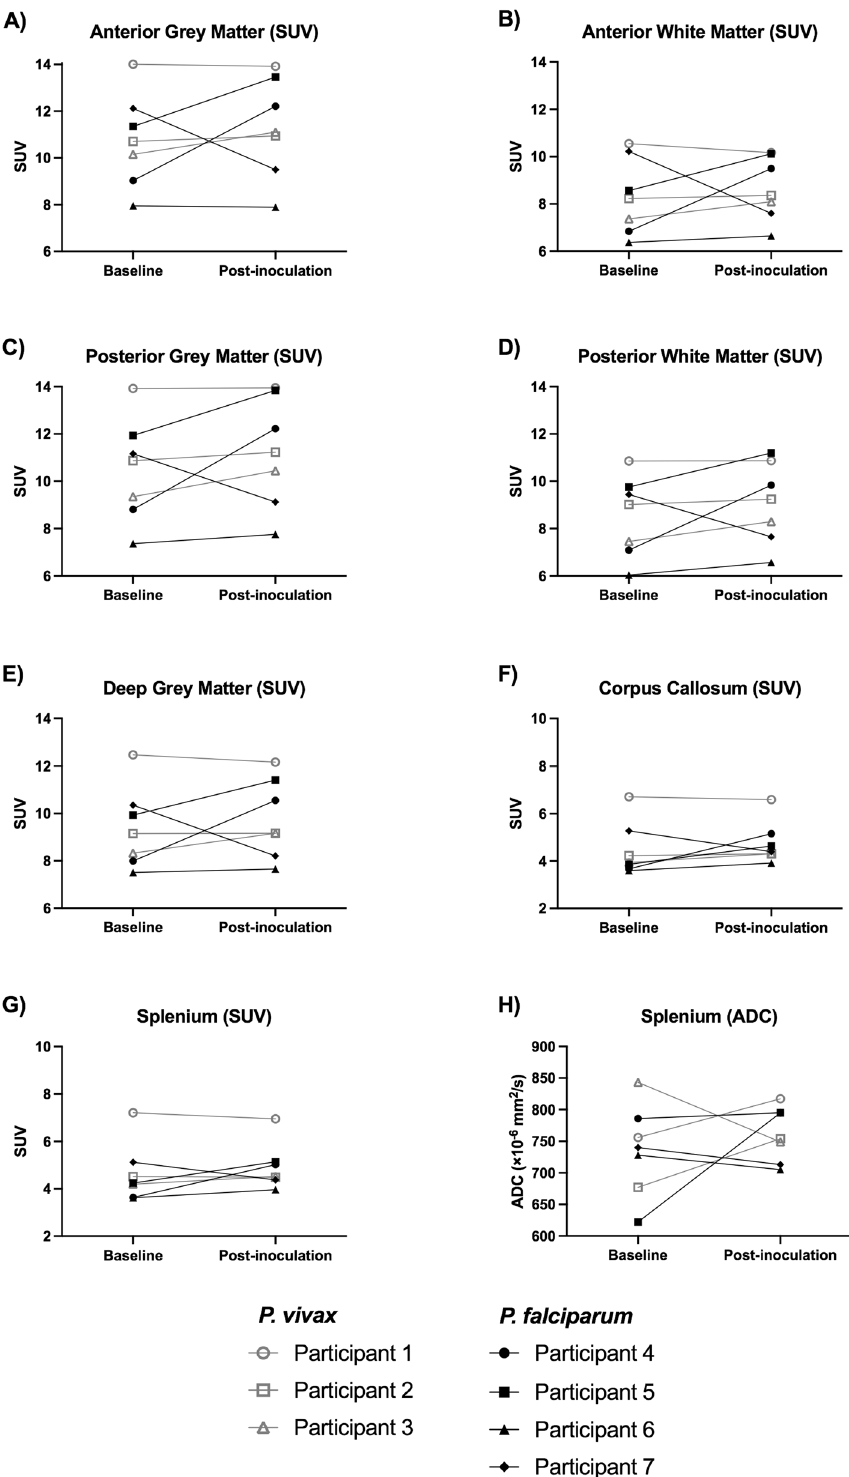
Figure 1. Imaging indices at baseline and post-inoculation. ( A ) Anterior grey matter SUV, ( B ) Anterior white matter SUV, ( C ) Posterior grey matter SUV, ( D ) Posterior white matter SUV, ( E ) Deep grey matter SUV, ( F ) Corpus callosum SUV, ( G ) Splenium SUV, ( H ) Splenium ADC, SUV: mean standardized uptake value, ADC: apparent diffusion coefficient. P. vivax participants represented by grey lines with unfilled markers, P. falciparum participants represented by black lines with filled